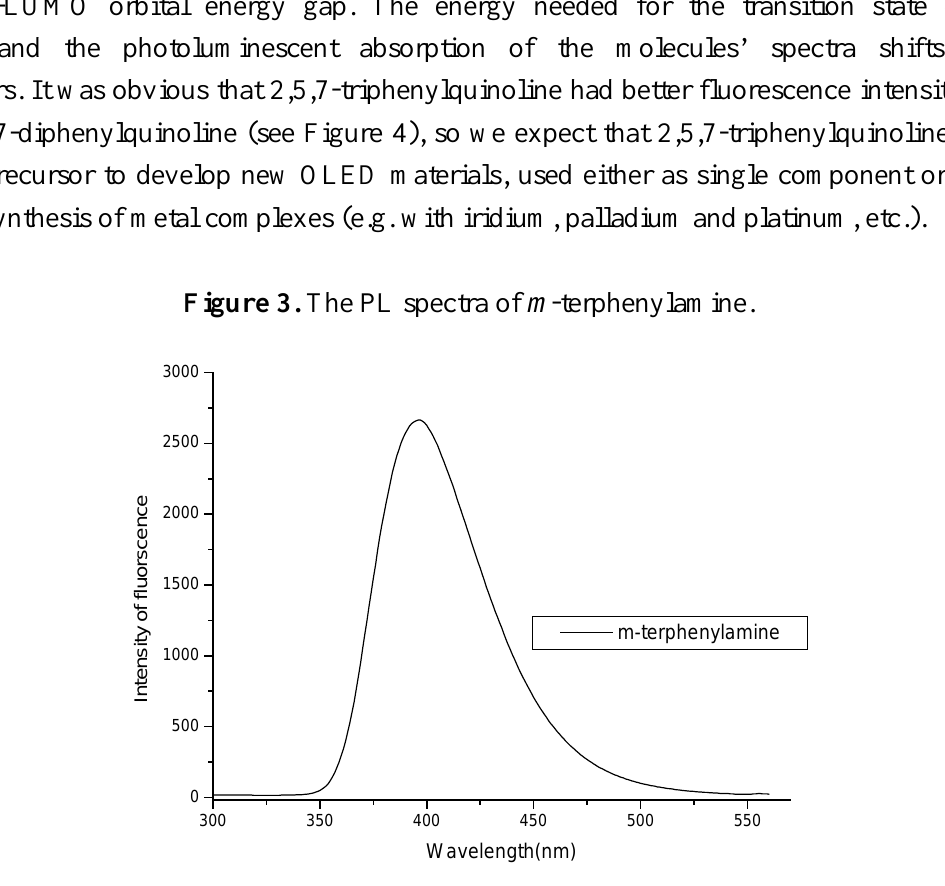
Figure 4. The PL spectra of 5, 7-diphenylquinoline and 2, 5,